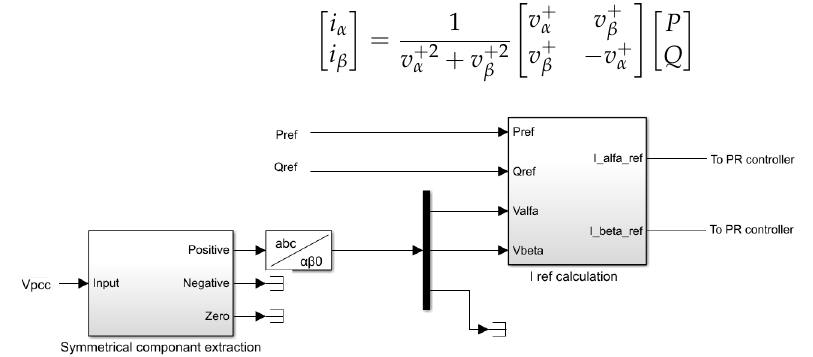
Figure 7. Reference current calculation under unbalanced PCC